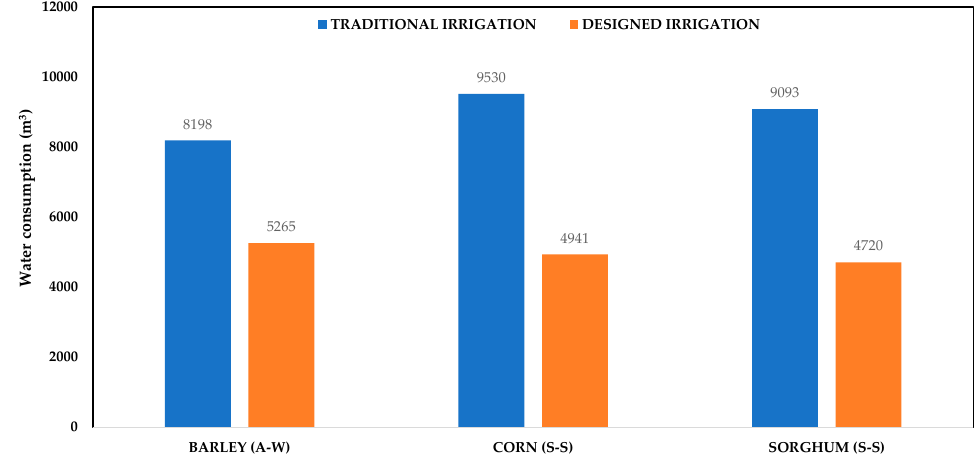
Figure 5. Water consumption in a traditional and design irrigation.